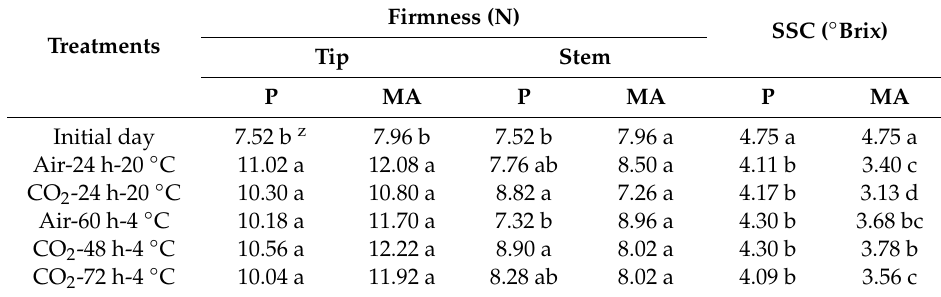
Table 2. Changes in firmness and soluble solids content (SSC) in green asparagus tip and stem tissues packaged with P or MA films on the initial and final storage days (the 25th day in P packages and the 30th day in MA